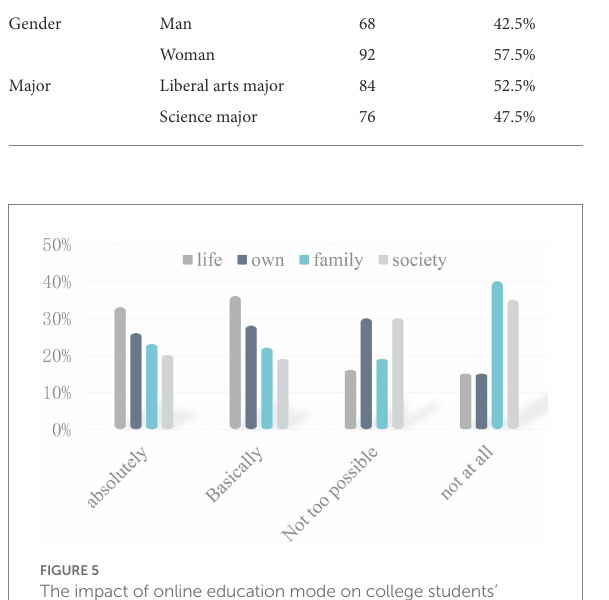
FIGURE 5 The impact of online education mode on college students’ learning cognition. FIGURE 6